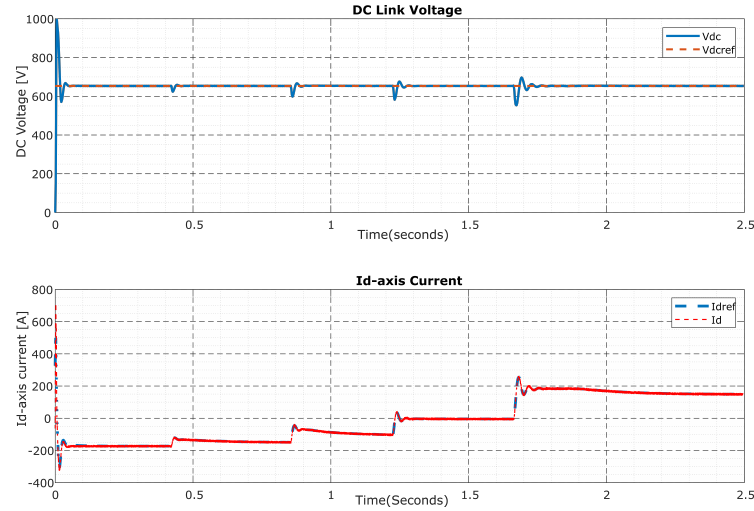
Figure 17. Vdc link and Id-axis current controls [21], © 2021 IEEE.